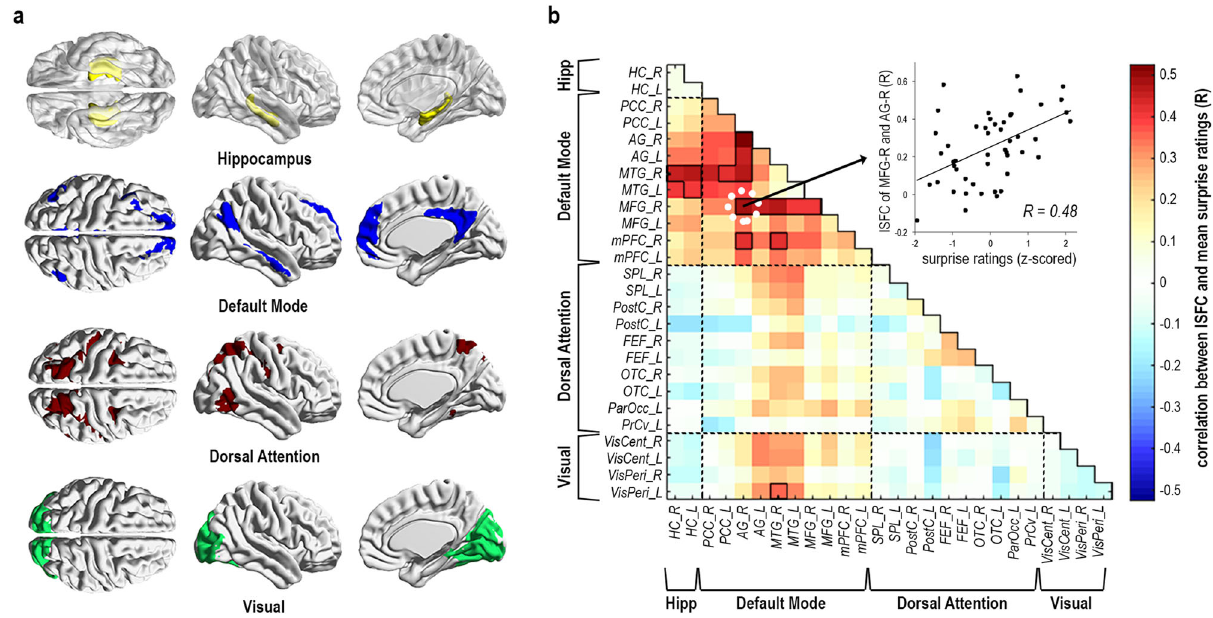
Fig. 2 Correlation between surprise ratings and coactivations in Sherlock. Rather than extracting correlations across all brain regions, the analysis was hypothesis-driven, focused on the network of interest (DMN), hippocampus, and two distinct control networks (DAN, Vis), thereby limiting in advance the number of tested comparisons. a Brain-maps denoting hippocampus (yellow), DMN (blue), DAN (red), and Vis (green). b Correlation SFPA — Pearson correlations were calculated between surprise ratings (mean of 45 behavioral participants) and ISFC of each region-pair (mean of 35 fMRI participants), across the time-course of n = 49 movie events. Black outlines denote above-chance correlations at p < 0.05 (corrected), determined by random permutation testing (1000 iterations). Scatterplot illustrates the correlation between mean surprise and mean ISFC of the right middle frontal gyrus (MFG) and angular gyrus (AG) across movie events. Regions of interest: HC hippocampus, PCC posterior cingulate cortex, AG angular gyrus, MTG middle temporal gyrus, MFG middle frontal gyrus, mPFC medial prefrontal cortex, SPL superior parietal lobe, PostC postcentral gyrus, FEF frontal eye fi eld, OTC occipital temporal cortex, ParOcc parietal occipital cortex, PrCv precentral ventral region, VisCent visual central areas, and VisPeri visual peripheral